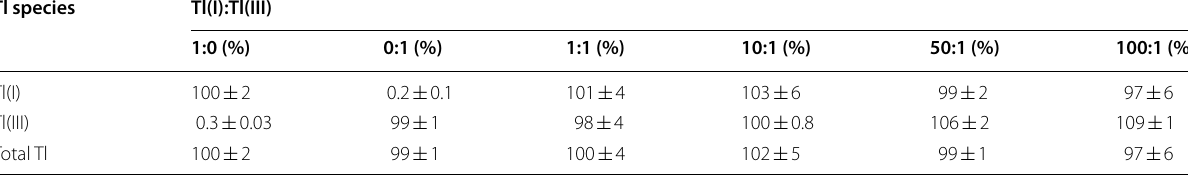
The samples, all of 10 mL volume, contain 350 ng Tl(I) (1:0 column), 380 ng Tl(III) (0:1 column), or solutions containing 380 ng Tl(III) and concentrations ratios of 1-, 10-, 50- and 100-fold larger of Tl(I) in 10 mL samples were tested. The results are presented as mean values Table 3 The recovery of Tl(I) and Tl(III) from samples at different pH